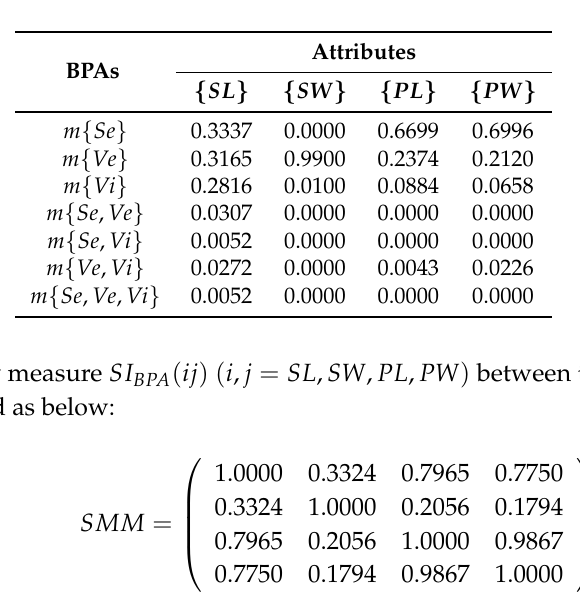
Table 5. The BPAs of Iris flower